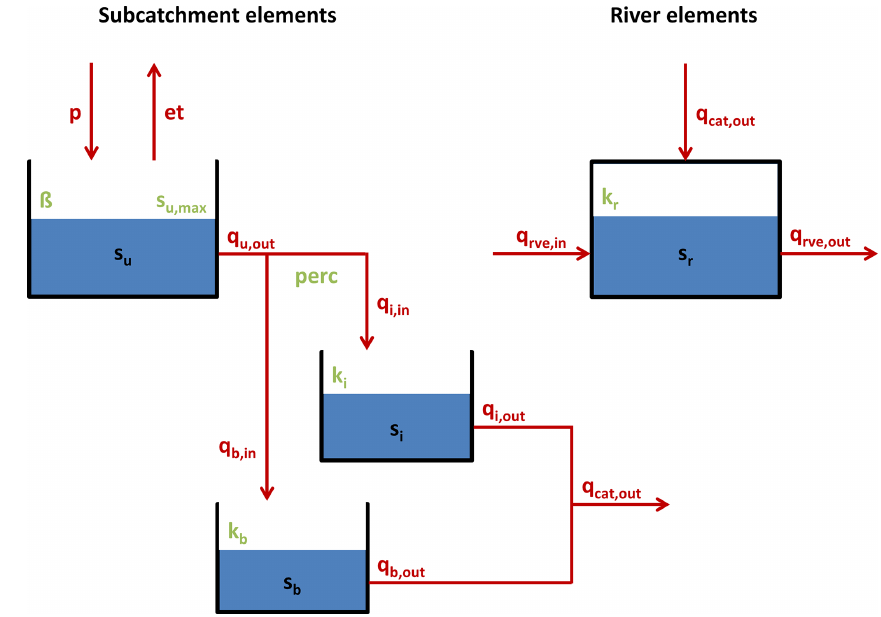
Figure A1. Structural elements, parameters (green), state variables (black), and fluxes (red) of the SHM